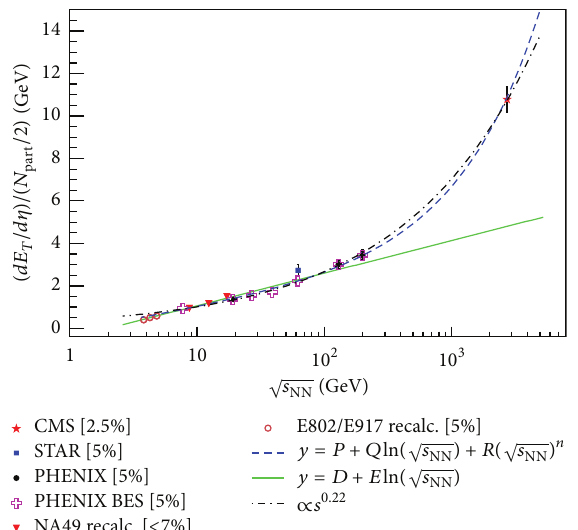
/ part Figure 37: Centrality dependent participant pair-normalized /𝑑𝜂 at midrapidity. 𝑑𝐸 𝑇